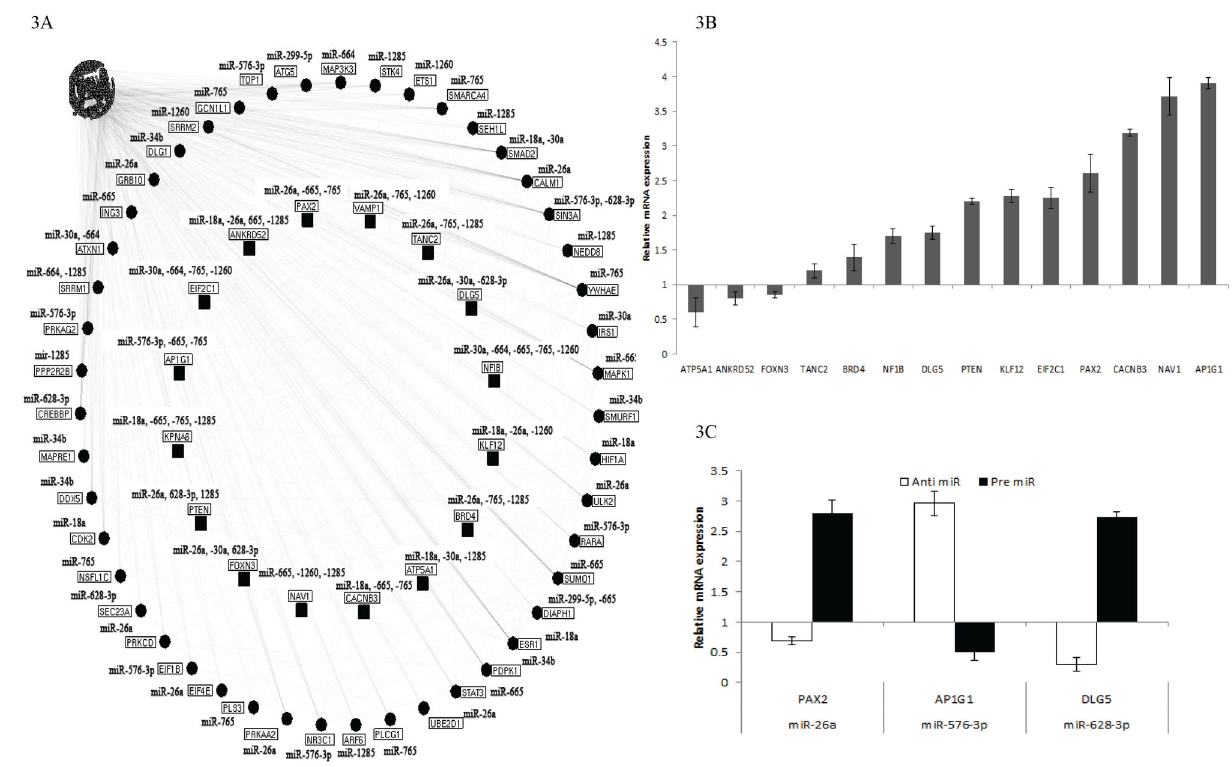
Figure 4. Effect of influenza infection on host genome. ( A ) Map of Proteome interaction due to H1N1 infection . The impact of the 14 dysregulated miRNAs on the protein expression and their corresponding interacting partners are shown here. The circle nodes represent individual proteins with high interactions (> 100) with other proteins within the system. The square nodes represent the proteins targeted by at least 3 miRNAs from the selected 14-miRNA cluster. ( B ) mRNA expression levels in influenza infected A549 cells . The transcript levels of the sixteen crucial proteins were determined using real-time PCR. Cycle threshold values were normalised to endogenous control 18S and expressed in relation to healthy controls. All experiments (n=3) were performed in triplicates. Data represents average of relative expression ± SEM. ( C ) Modulation of miRNA levels . mRNA expression levels in influenza infected A549 cells transfected with anti or pre miRNAs. The changes in the transcript levels were determined using real-time PCR. Cycle threshold values were normalised to endogenous control 18S and expressed in relation to infected A459 cells transfected with scrambled miRNAs. All experiments (n=3) were performed in triplicates. Data represents average of relative expression ±